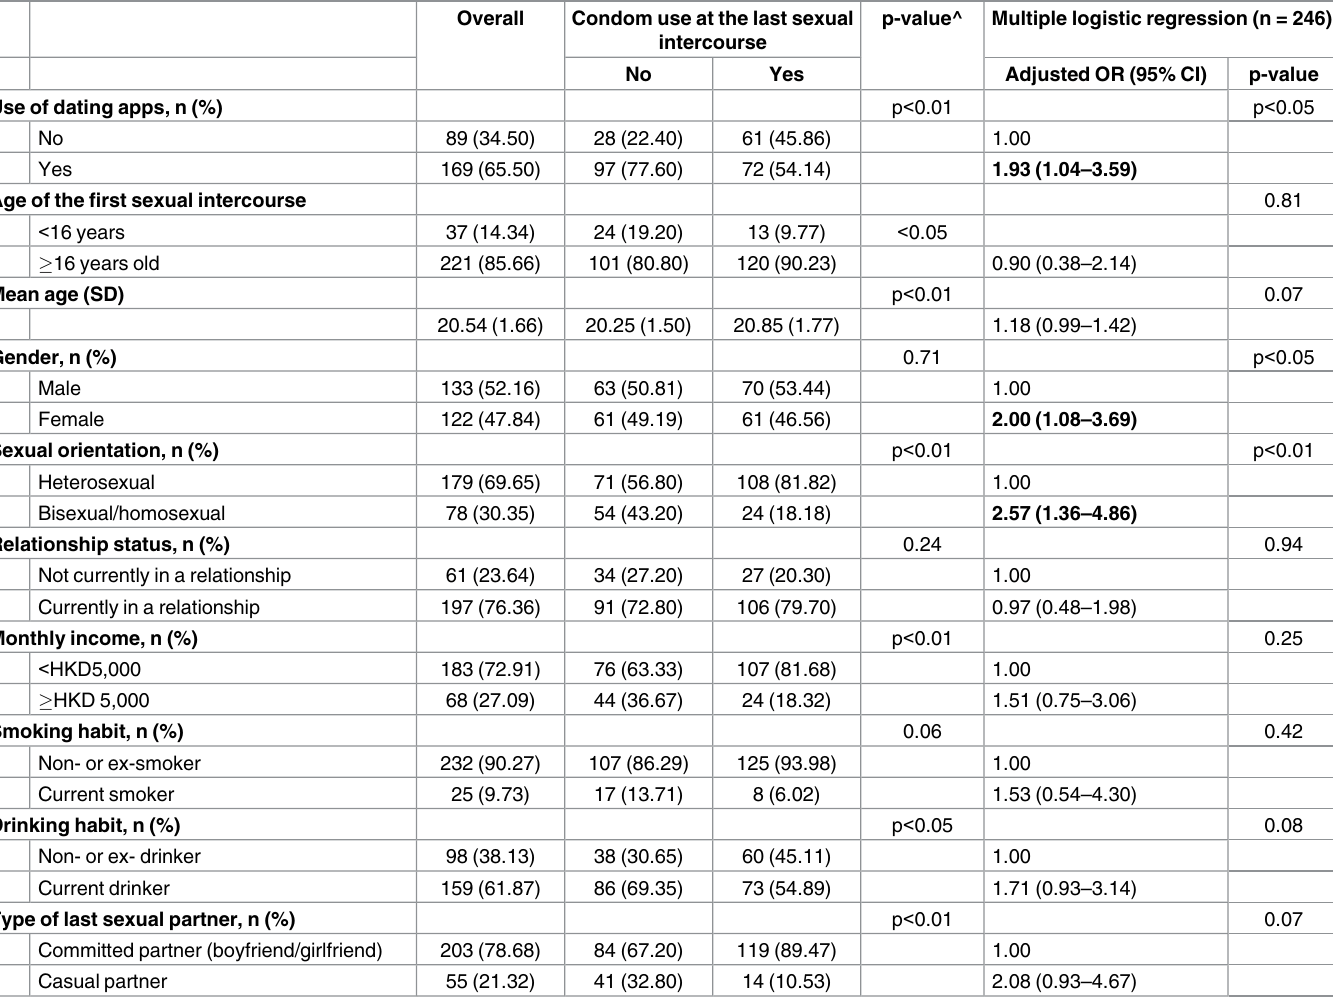
Table 7. Correlates of condom use at the last sexual intercourse by multiple logistic